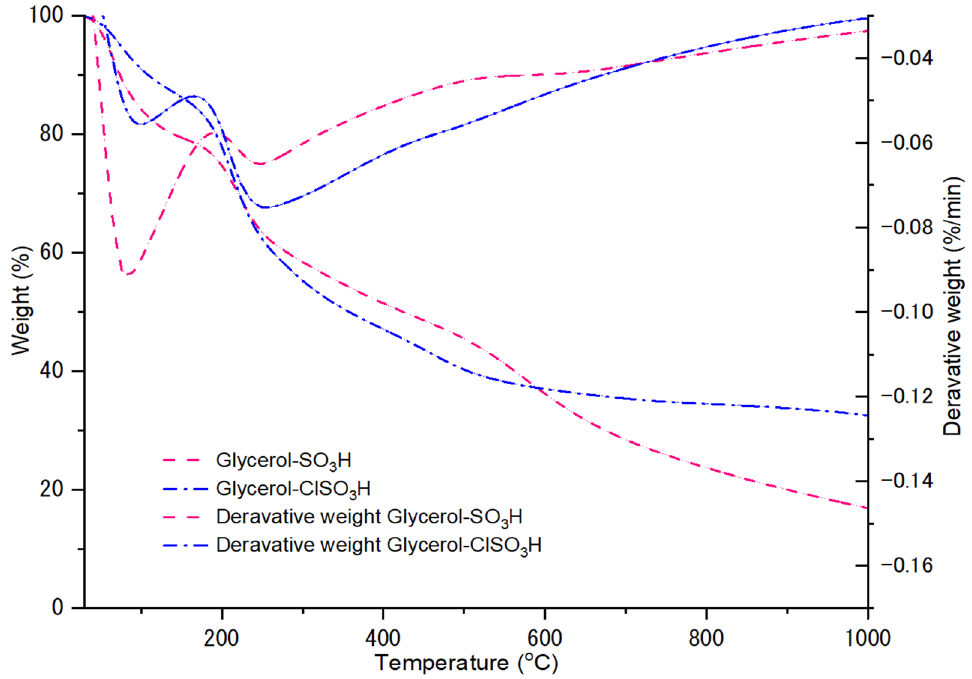
Figure 1. Thermal decomposition analysis of glycerol-SO 3 H and glycerol-ClSO 3 H catalyst.